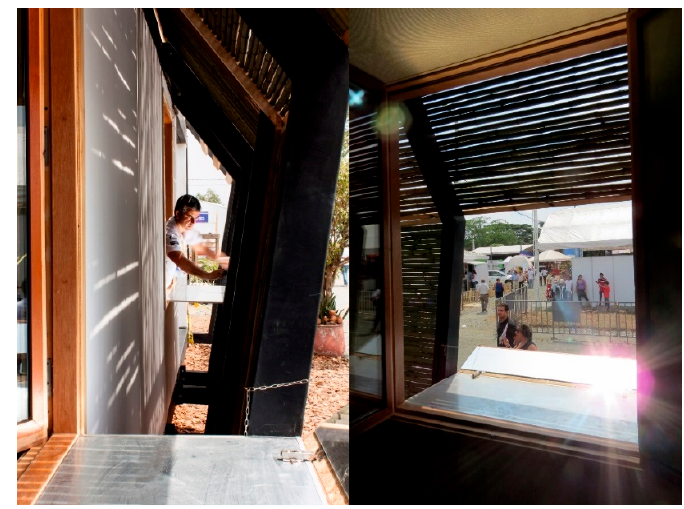
Figure 18. Image of one of the solar reflectors.